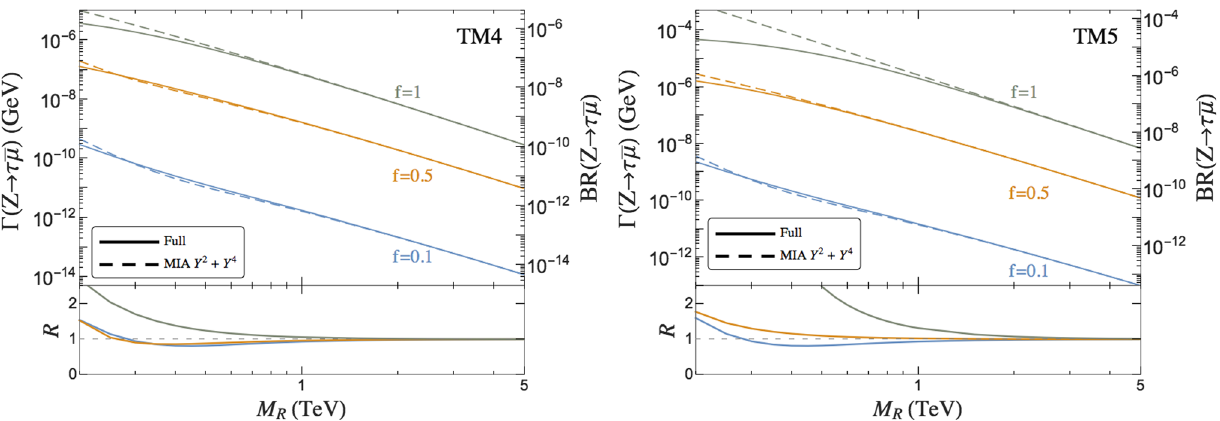
examples TM4 (left panel) and TM5 (right panel) with f=0.1,0.5,1, as explained in the text, are chosen. In the bottom of these plots the ratio R = (cid:5) MIA /(cid:5) full is also